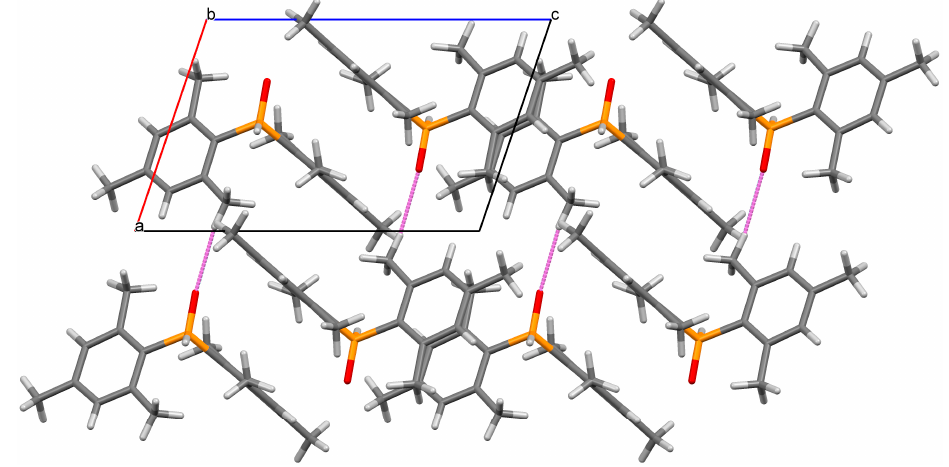
Figure 2. Packing diagram showing the close contacts in the crystal of 1 when viewed along the b axis. Selected distance (Å): O1–H16C 2.561(2).